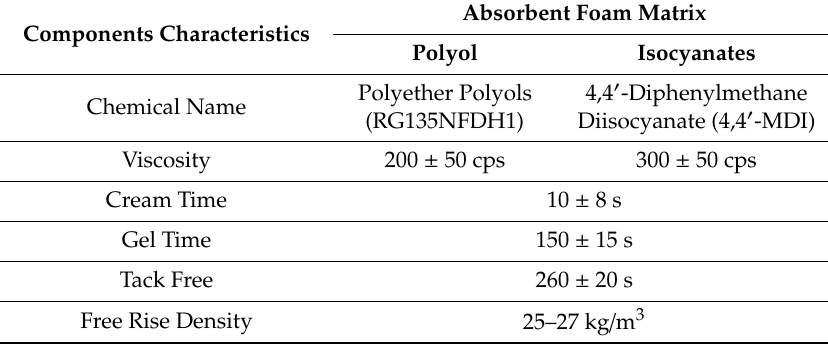
Table 1. Detailed information on the matrix-based components used in MR foam